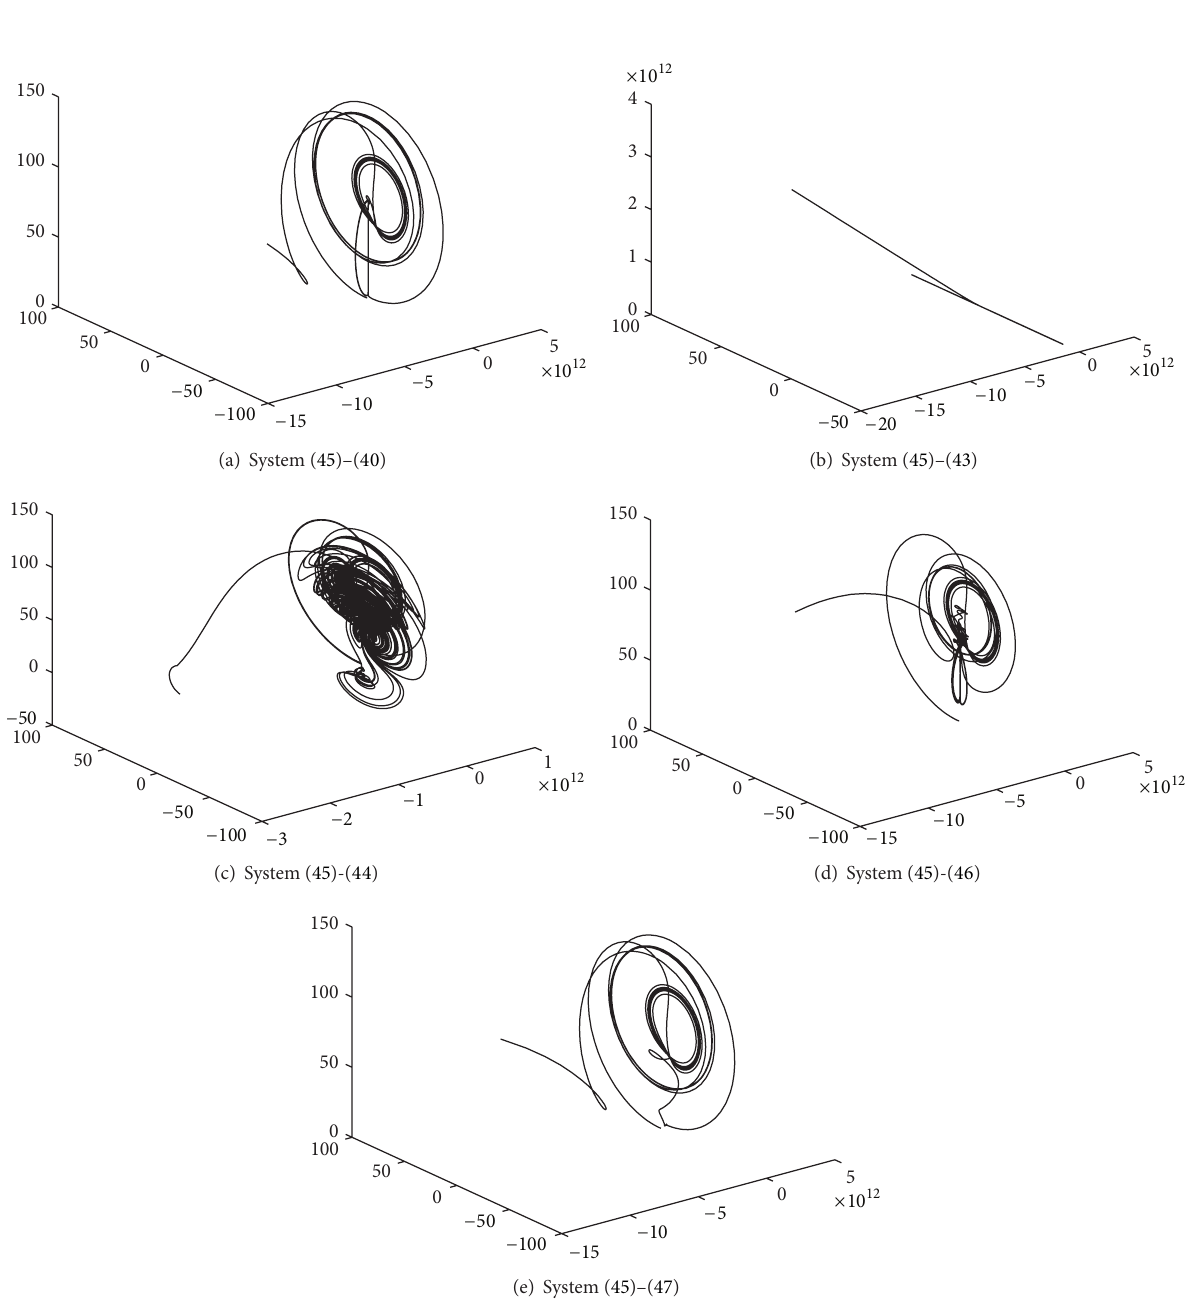
Figure 10: Switched system between Example (45) and